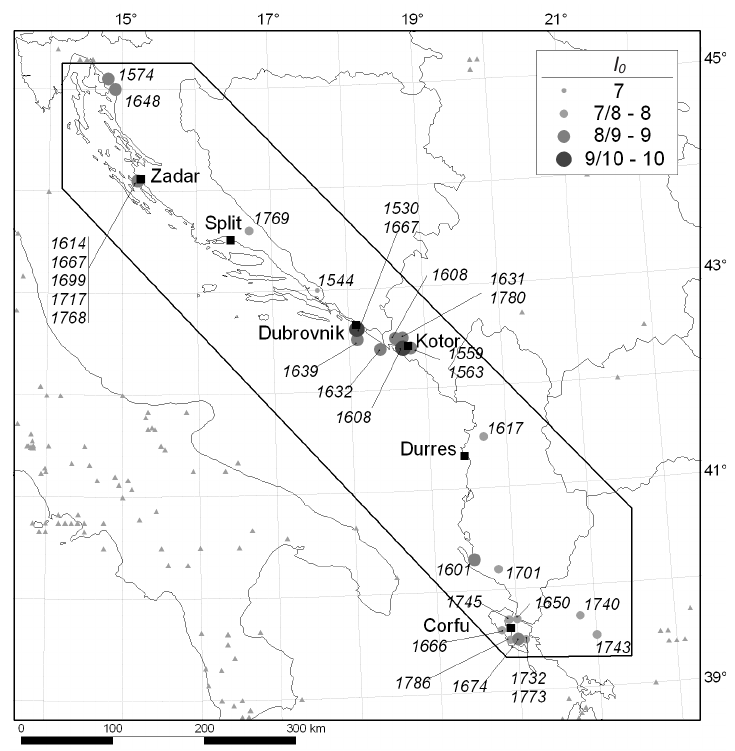
Fig. 8. Seismicity in the Eastern Adriatic between 1530 and 1806 according to parametric earthquake